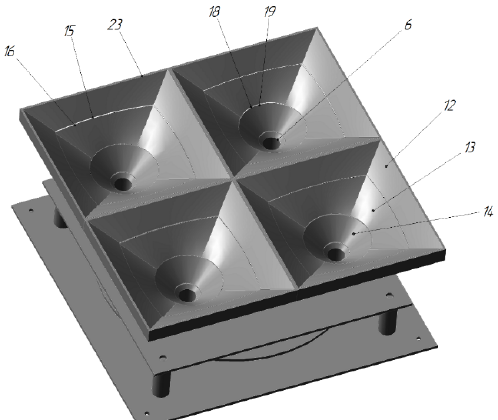
Figure 22. Landing platform for a UAV with funnels divided into horizontal tiers [66] by Innopolis University. 6, holes for legs; 12, 13, and 14, funnel